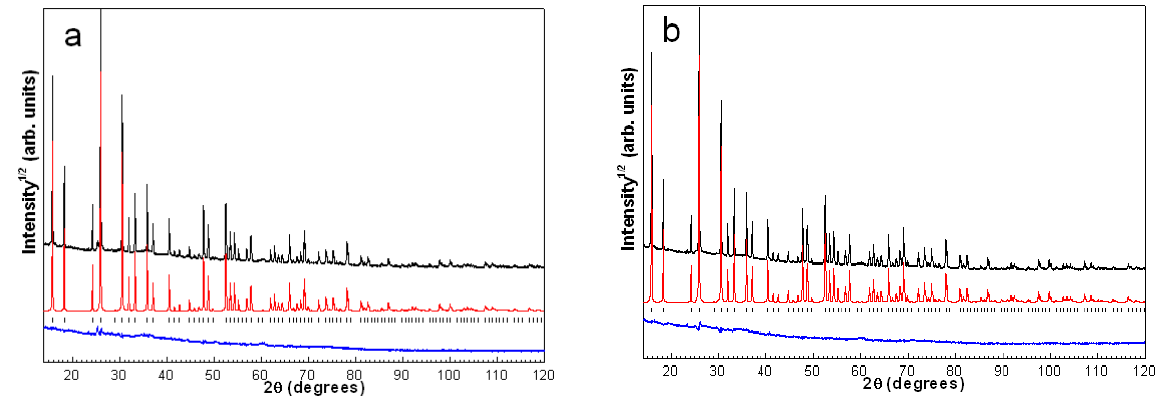
Figure 7. Observed (top, black), calculated (mid, red) and difference (bottom, blue) PXRD profiles after DDM crystal structure refinement for samples ( a ) ANA and ( b ) 1000Sr/ANA-200.